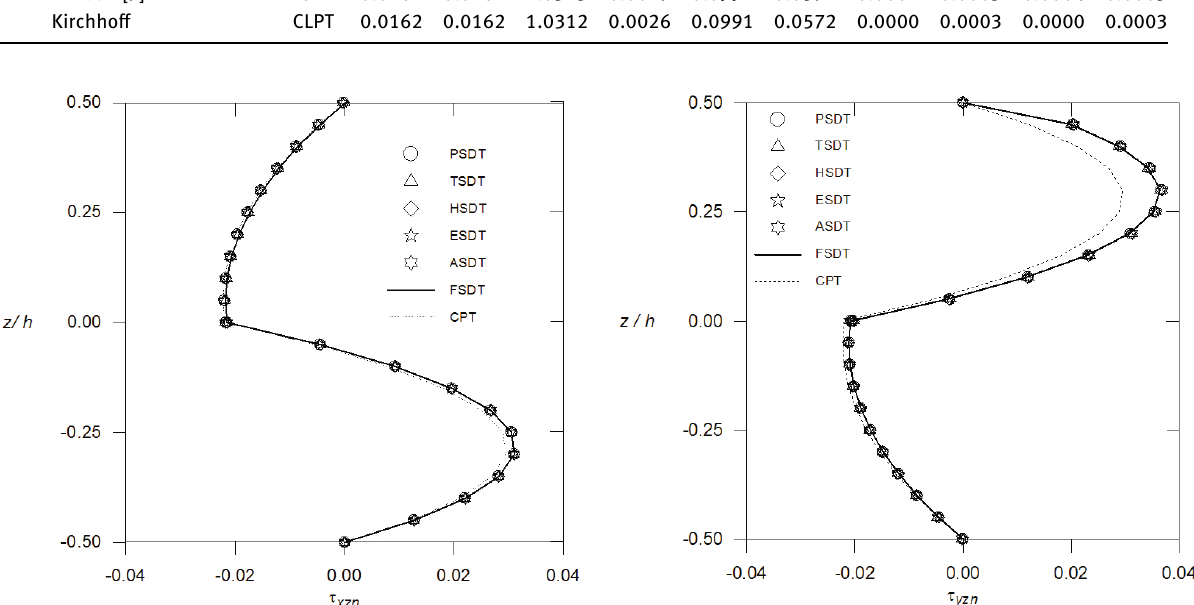
Figure 5: Variation of normalized transverse shear stress τ yz across the thickness for two layered (0 ∘ /90 ∘ ) anti-symmetric laminated composite square plate for aspect ratio